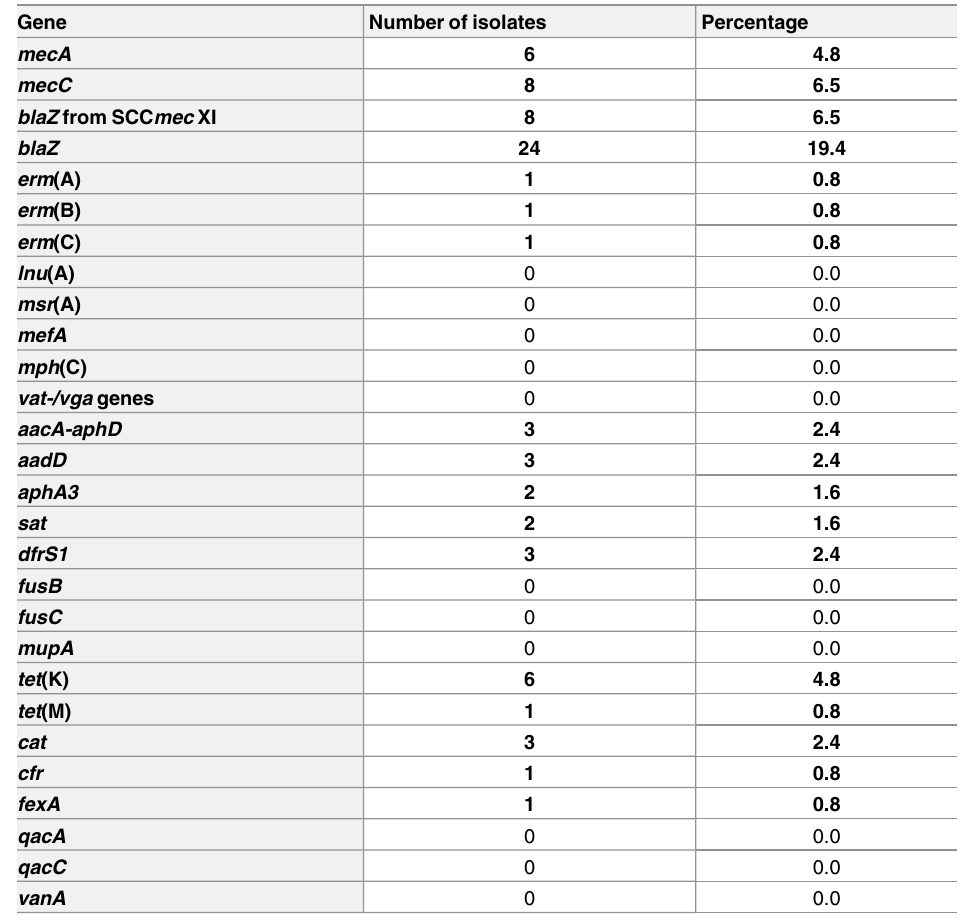
Table 3. Prevalence of resistance genes in 124 S . aureus isolates from